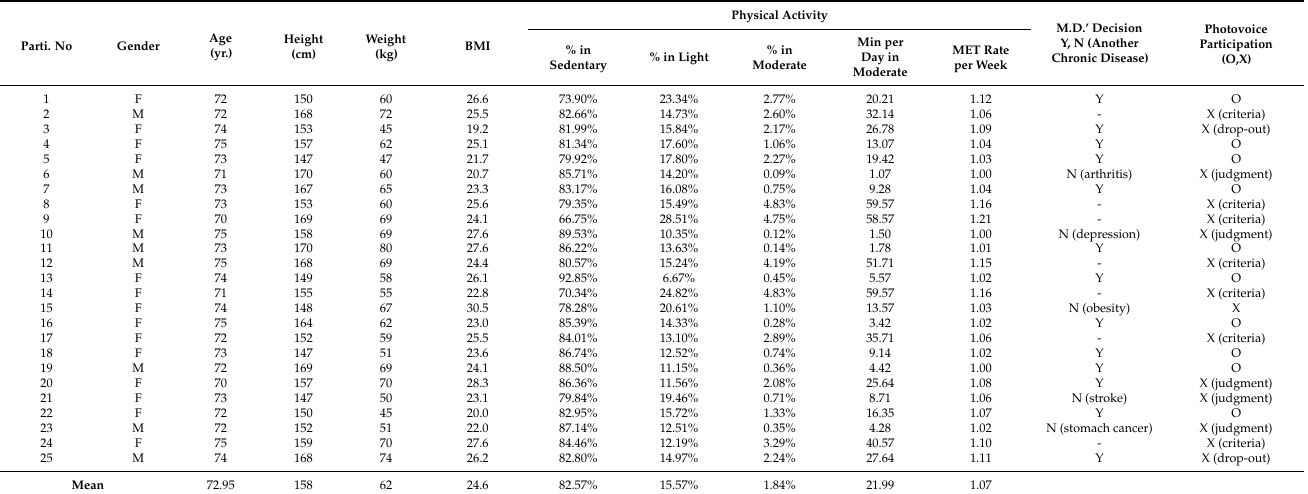
Table 4. Physical Activity Data for a week measured by an accelerometer.